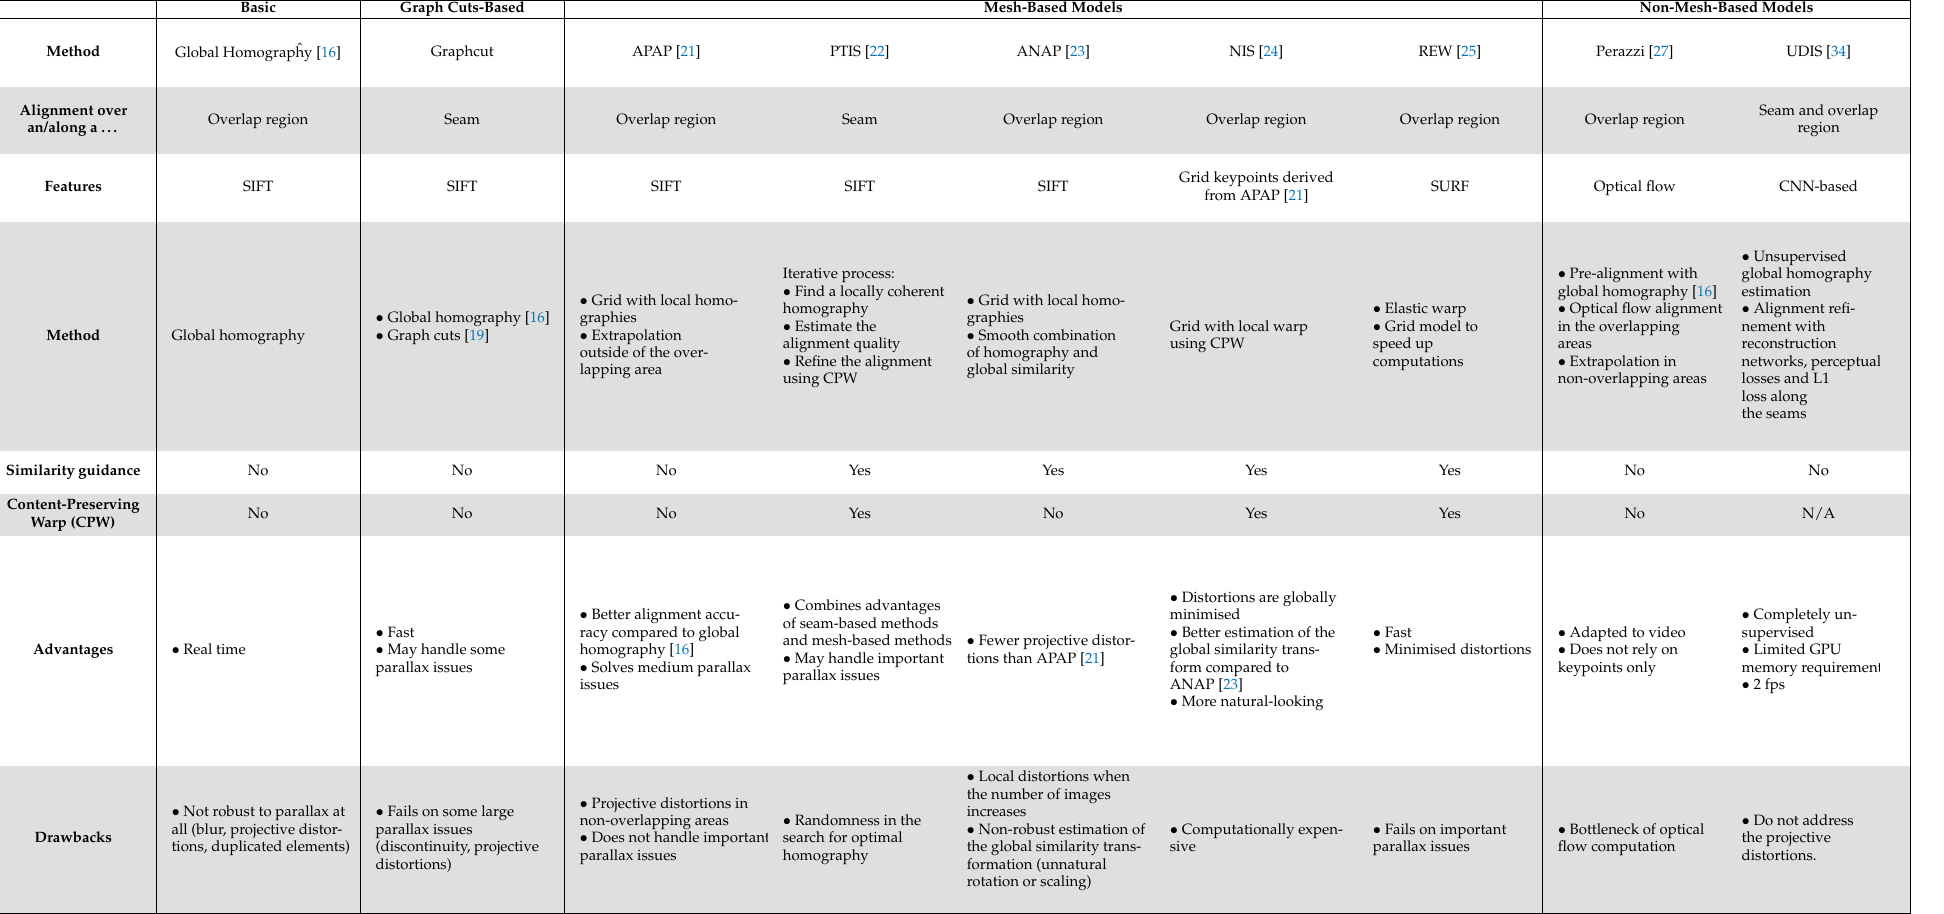
Table 1. The main characteristics of image stitching algorithms from the non-medical